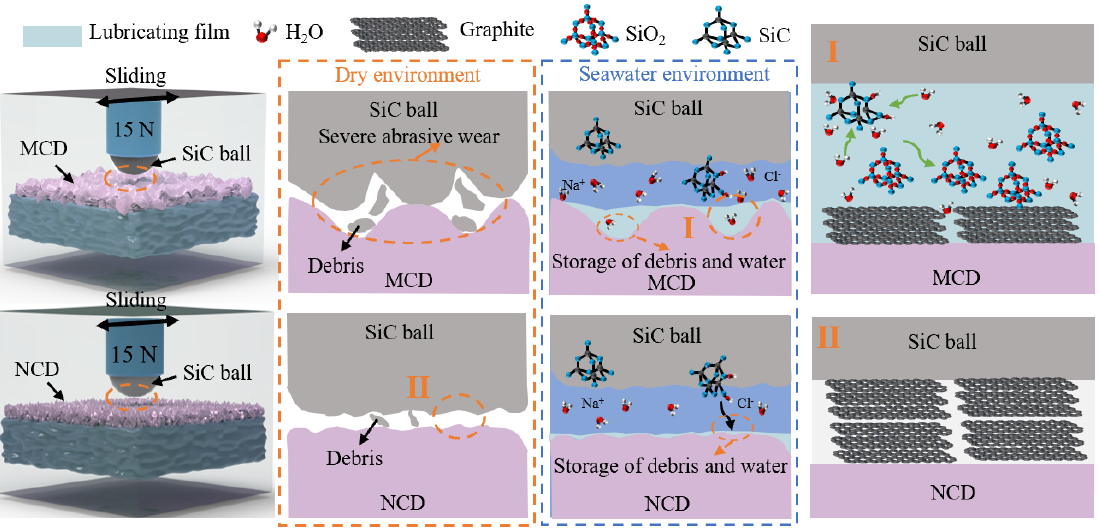
Figure 10. Schematic illustration of wear mechanism in dry friction and seawater